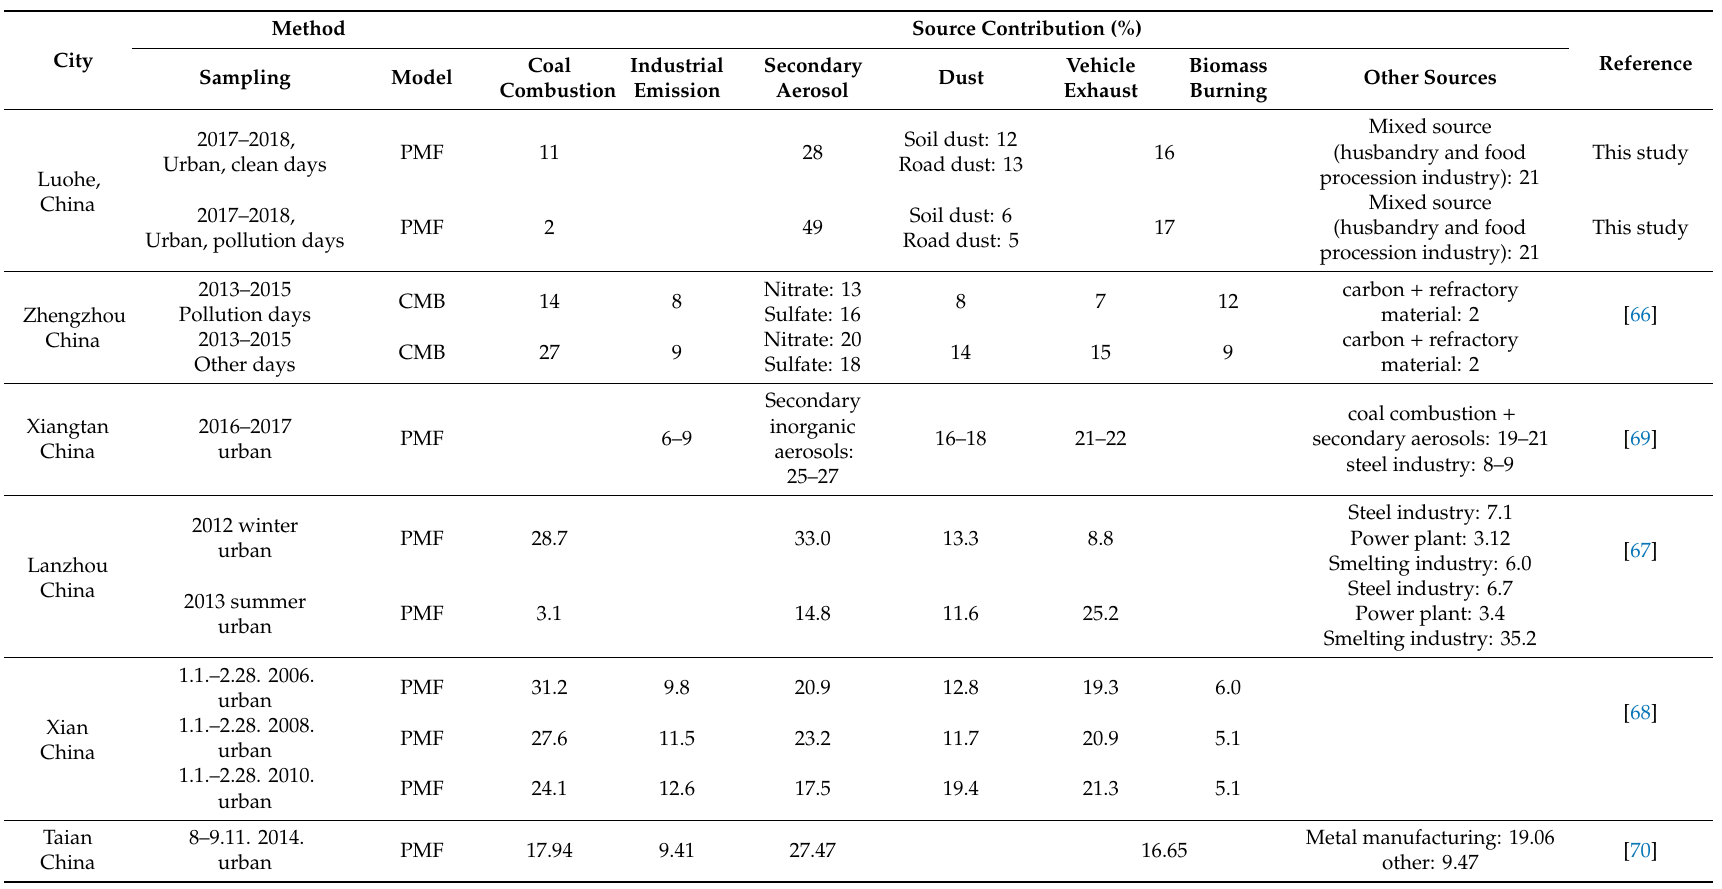
Table 3. Comparison of source apportionment with other